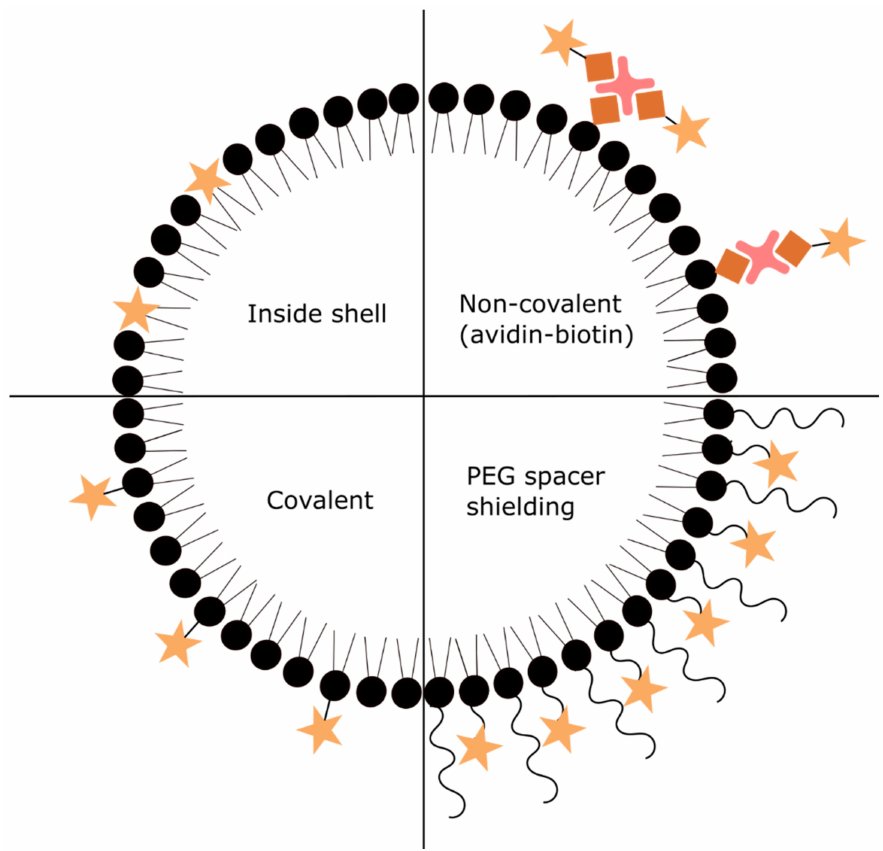
Figure 4. Schematic representation of di ff erent functionalization methods of